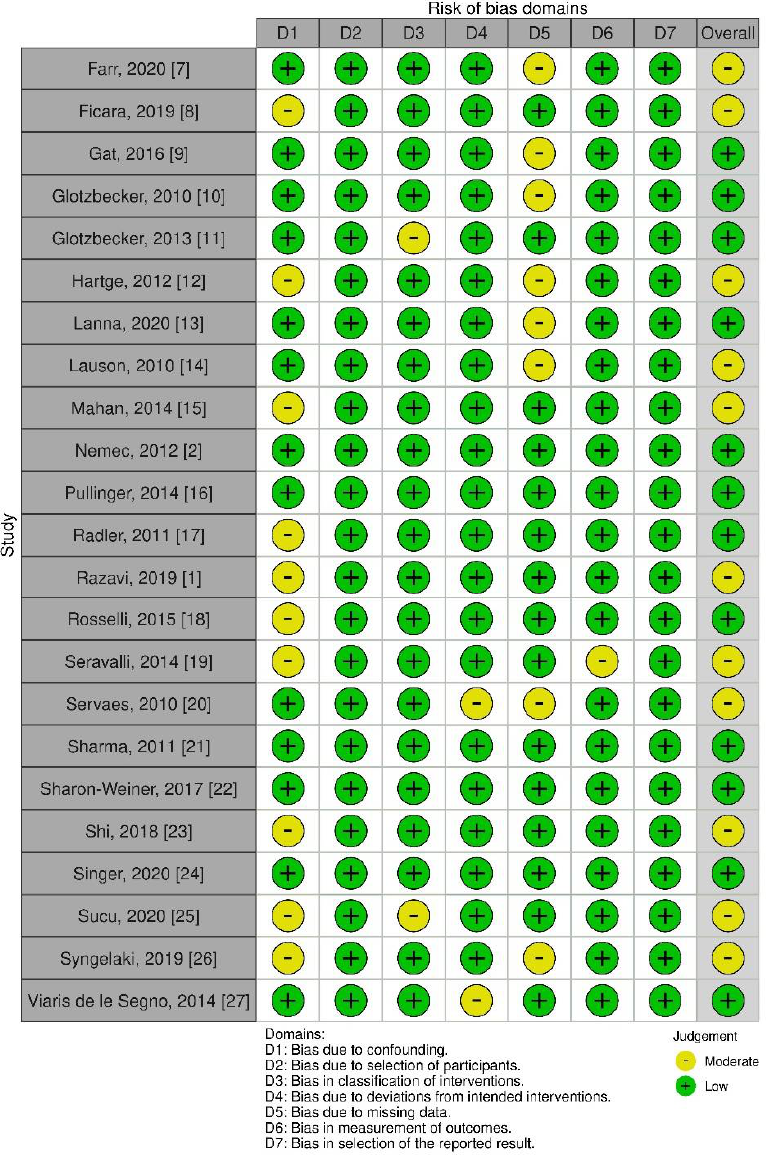
Figure 2. The risk of bias assessments for NRCTs studies with ROBINS-I